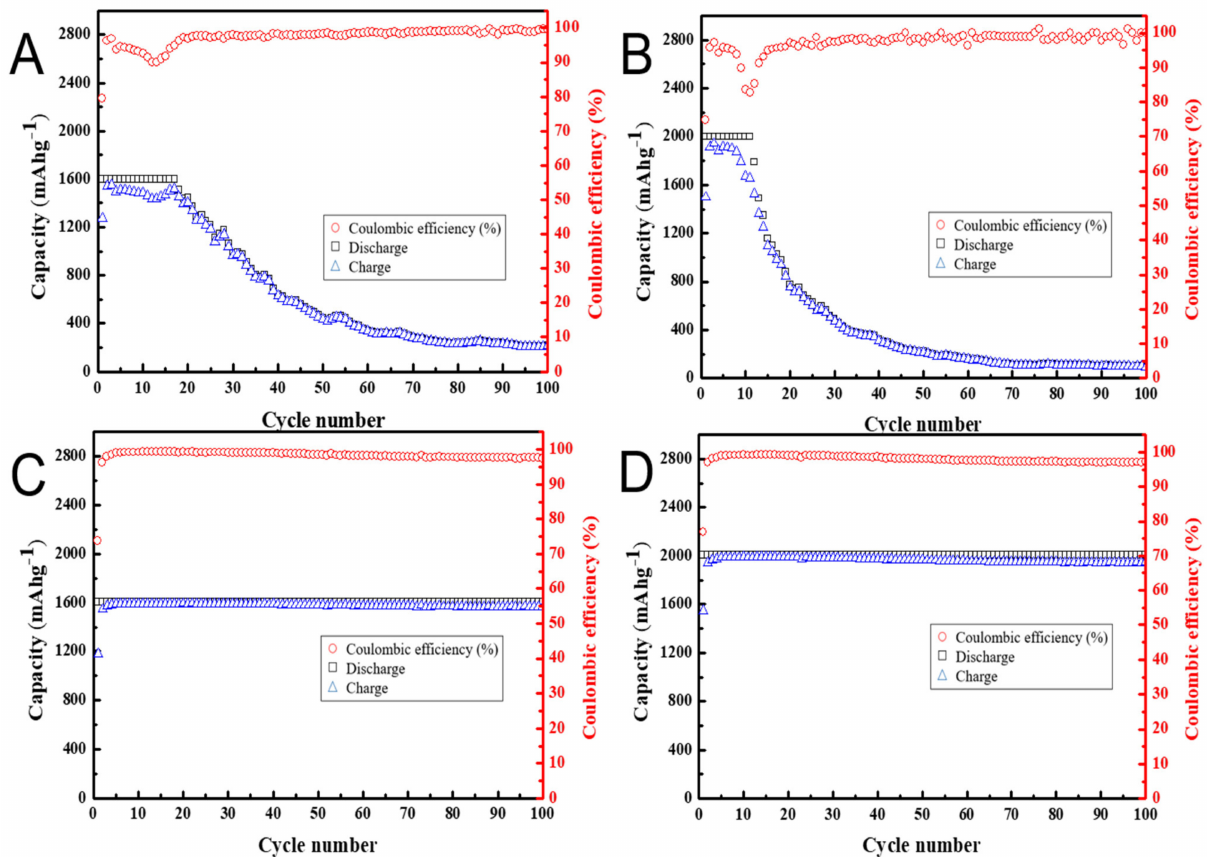
Figure 10. Cycling performance at the maximum lithiation (discharge) capacity of ( A , C ) 1600 mAh/g and ( B , D ) 2000 mAh/g for anodes made of ( A , B ) as-received silicon flakes and ( C , D ) nanocarbon-coated silicon flakes at 650 ◦ C. The discharg- ing/charging rate is 0.01 C for the first three cycles and 0.1 C for remaining cycles. Only the weight of silicon is included in the calculation of the specific